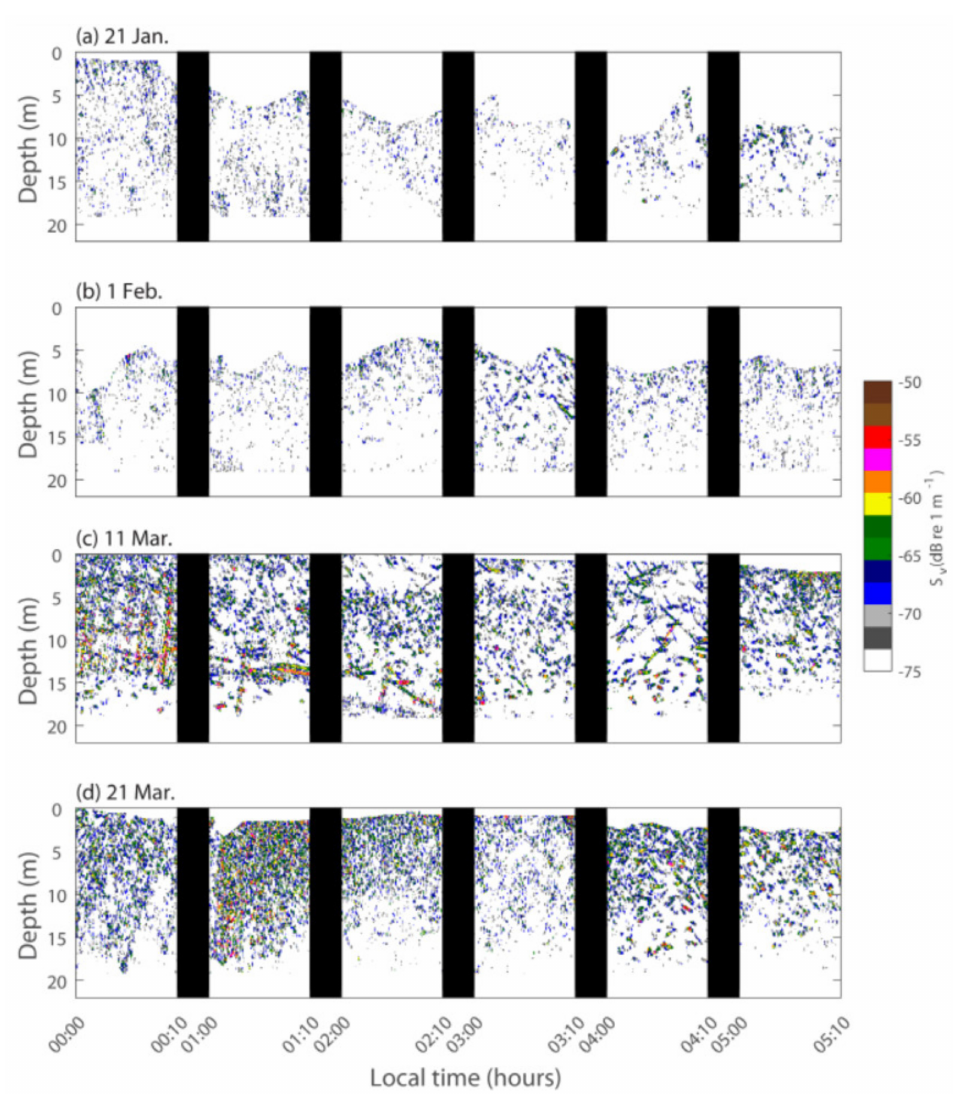
Figure 9. Echograms from the mooring highlighting the change in fish signals at the site. The records start at 0000, 0100, 0200, 0300, 0400, and 0500 h local time on ( a ) 21 January , ( b ) 1 February, ( c ) 11 March and ( d ) 21 March 2018, indicated and last 600